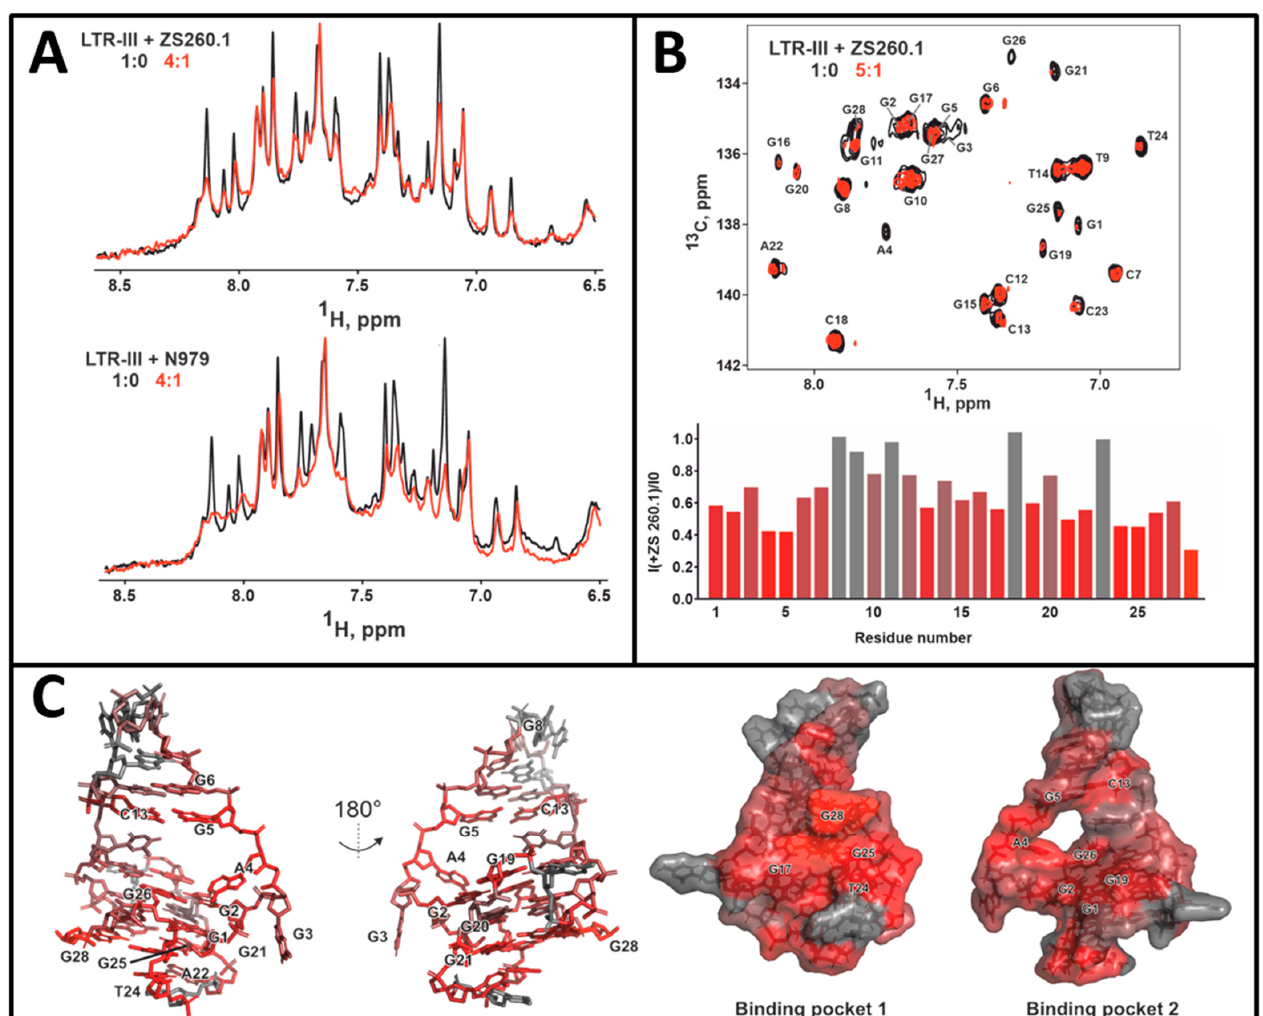
Figure 4. The results of NMR titration studies. ( A ) Changes in 1D 1 H spectra (region, corresponding to pyrimidine H6 and purine H8 protons) of 50 µ M LTR upon titration with ligands ZS260.1 and N979. ( B ) Overlay of 1 H- 13 C HSQC spectra of 0.5 mM LTR before (black) and after (red) addition of ZS260.1 (LTR-III/ZS260.1 = 5:1) at 25 °C ( top ). The assignment of H6/C6 (T, C) and H8/C8 (A, G) cross-peaks is shown. Diagram corresponds to the relative decrease in intensities upon the addition of ZS260.1 ( bottom ). ( C ) Nucleotides of the LTR-III G4 structure (PDB: 6H1K), most sensitive to the addition of ZS260.1 ( left ) and two possible binding pockets ( right ). The structure is colored according to attenuation of H6/C6 and H8/C8 cross-peaks in 1 H- 13 C HSQC spectrum (panel B , bottom ).